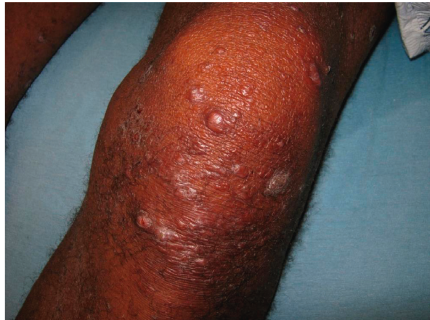
Figure 3: Lepromatous leprosy: lesion with diffuse thickening, numerous discrete, and confluent nodules (photograph courtesy of White, et al.)